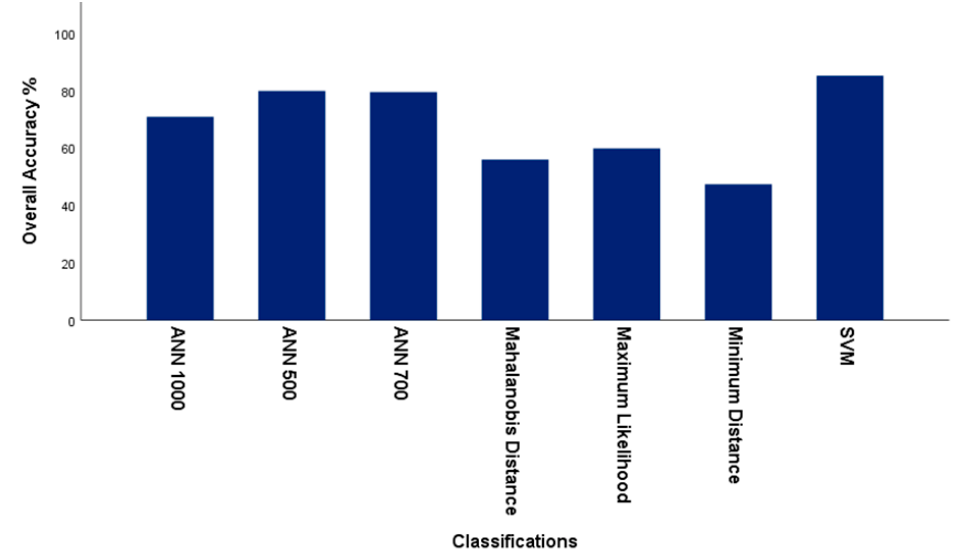
Figure 15. The overall accuracy of five types of classifications using machine learning and conventional-based approach.